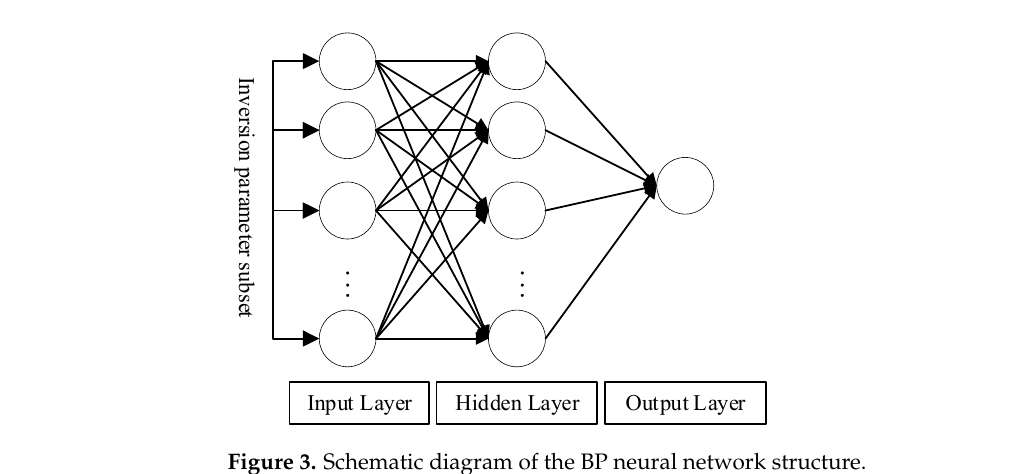
Figure 3. Schematic diagram of the BP neural network structure.